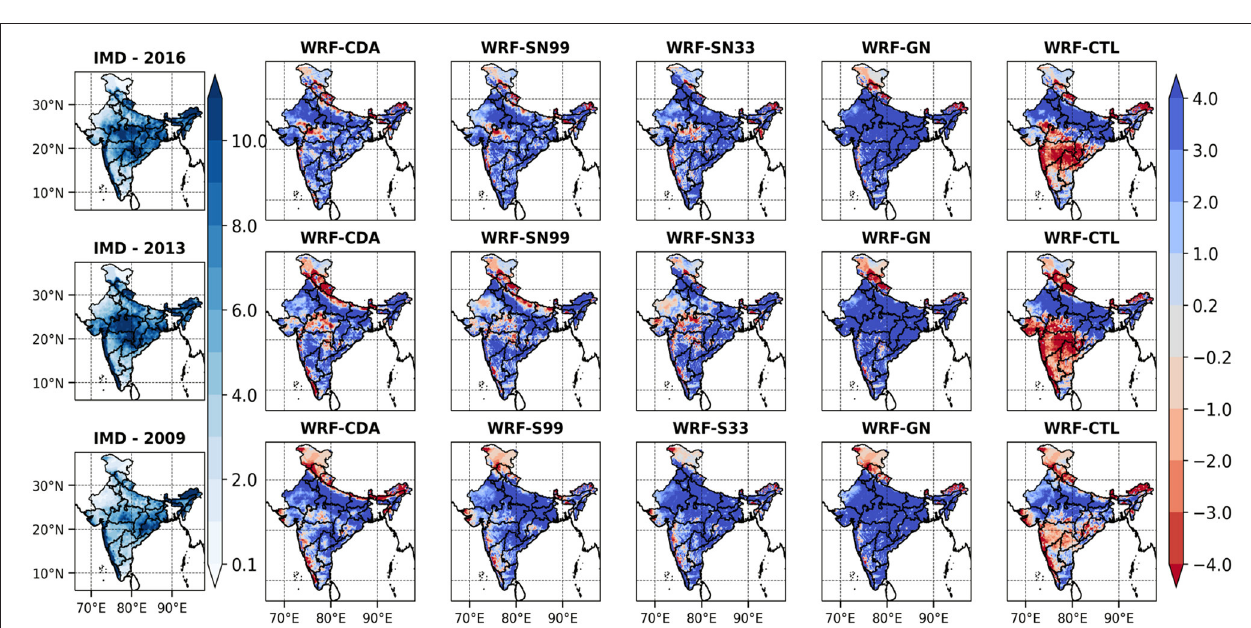
FIGURE 2 | The India Meteorological observed mean seasonal rainfall (mm/day, First column) during normal (2016), excess (2013), and drought (2009) Indian Summer Monsoon seasons. Second, third, fourth, fifth, and sixth columns are the seasonal mean rainfall differences between the model (WRF-CDA, WRF-SN99, WRF-SN33, WRF-GN, and WRF-CTL, respectively) and IMD observations for all three seasons. First row is for normal, second row is for excess, and third row is for drought Indian Summer Monsoon seasons.